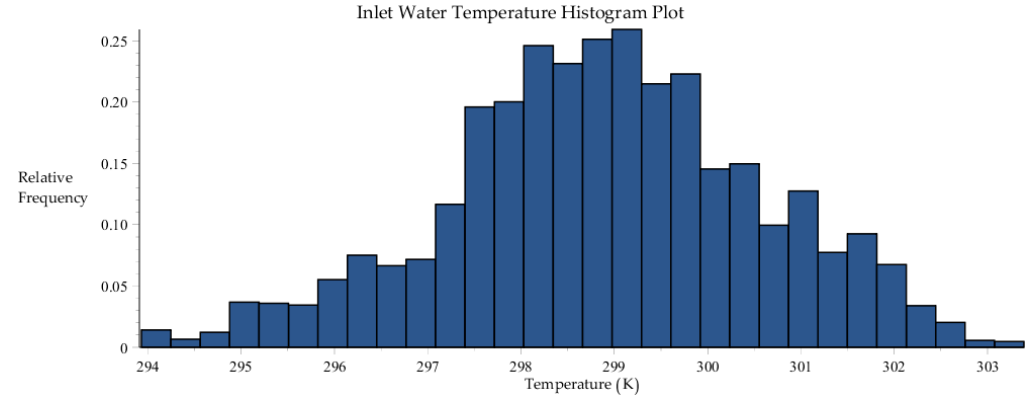
Figure B2. Histogram plot of dew-point air temperature data collected by SRNL from F-Area cooling towers. Energies 2016 , 9 , 1028